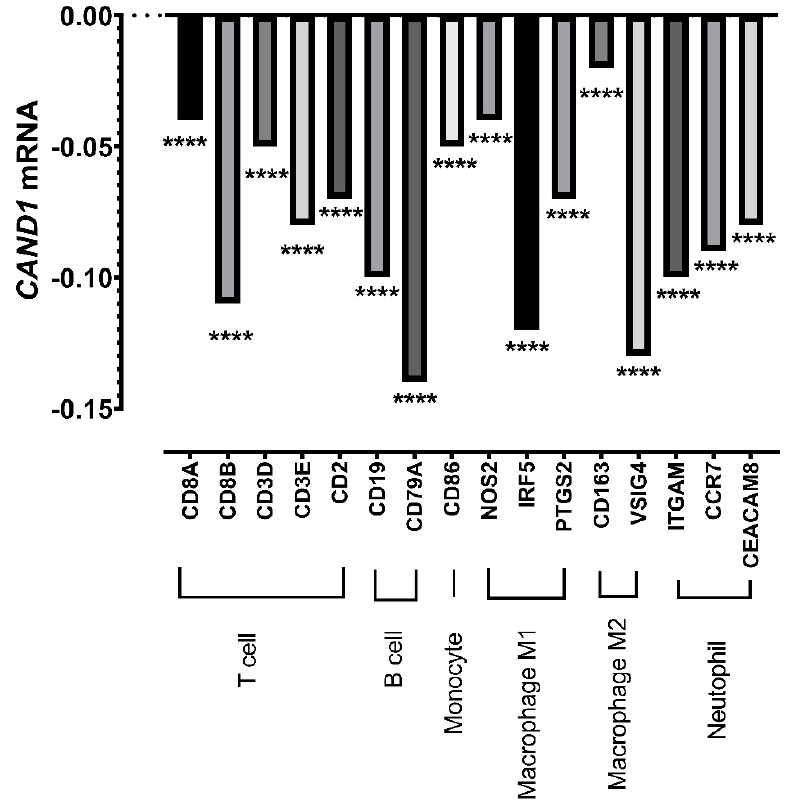
Figure 3. Pearson’s correlation coefficient between CAND1 mRNA and several gene markers of im- mune cells in ER α -positive breast cancer patients, including T cells, B cells, monocytes, macrophages M1 and M2, and neutrophils. **** p < 0.0001.